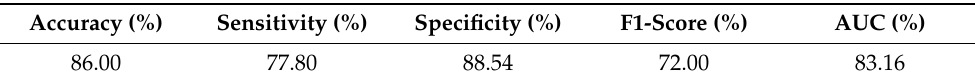
Table 6. Performance measures of the ECG-trained model on the complete UMass-DB PPG signals before transfer